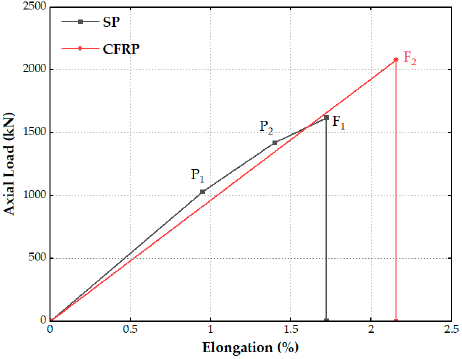
Figure 9. Tensile failure response of CFRP and SP.